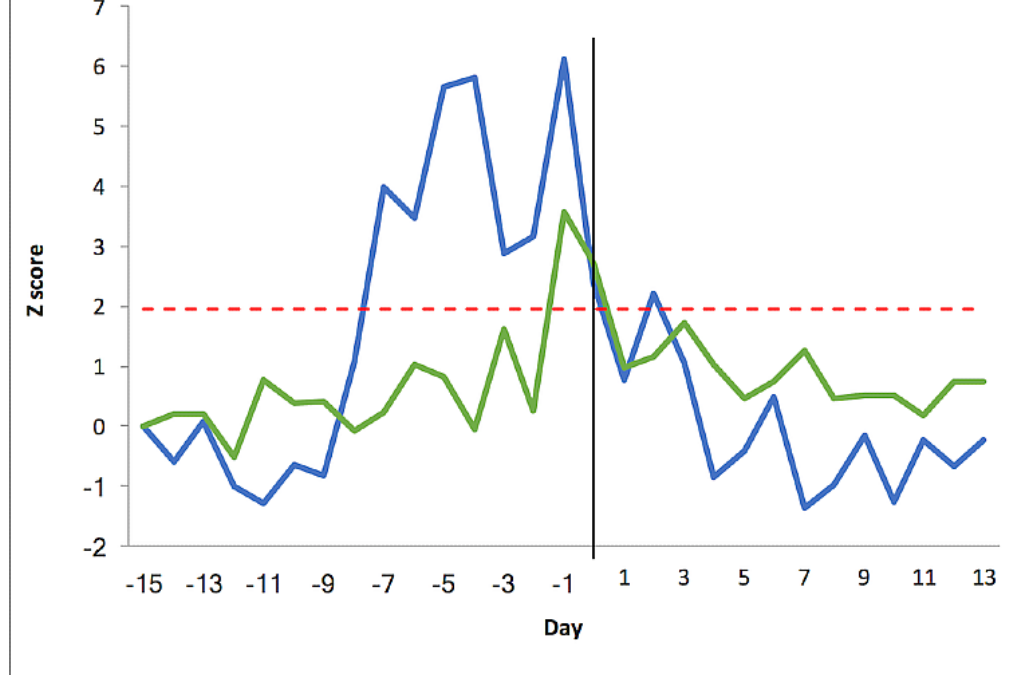
Figure 5. Composite pulse oximetry score changes pre and post exacerbation for the 27 patients with chronic obstructive pulmonary disease. The y-axis represents the Z score relative to the patient’s baseline mean. The x-axis represents the time expressed in days. Day −15 is the mean of the stable period, days −14 to −1 is the preexacerbation period, day 0 is the day of initiation of treatment for exacerbation, and days 1 to 13 is the postexacerbation recovery. The red line represents the threshold limit of +1.96 SD. The once-daily group is represented by the green line and the overnight group by the blue line.